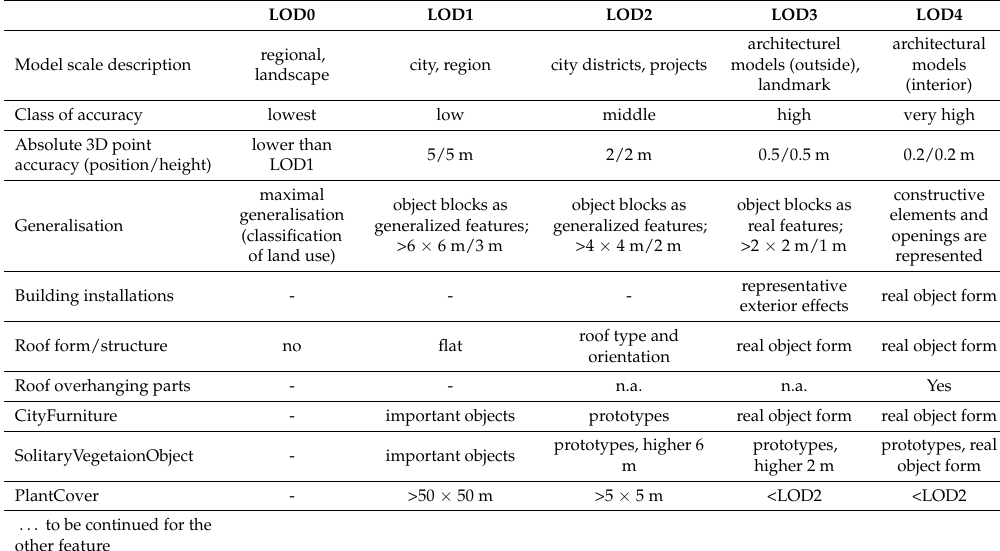
Table 1. LOD 0–4 of CityGML with its accuracy requirements